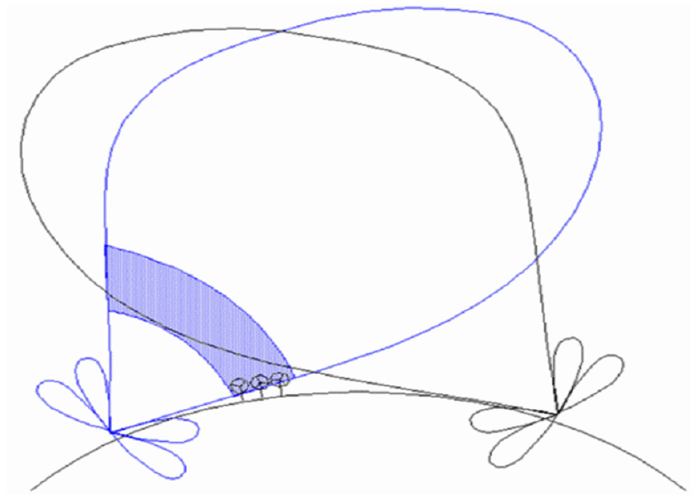
Figure 16. Illustration of sensor fusion as mitigation strategy against wind turbine clutter [62]. It can be observed that the radar is unaffected by wind turbine clutter. Lightning Strike Protection were elaborated upon in [62].